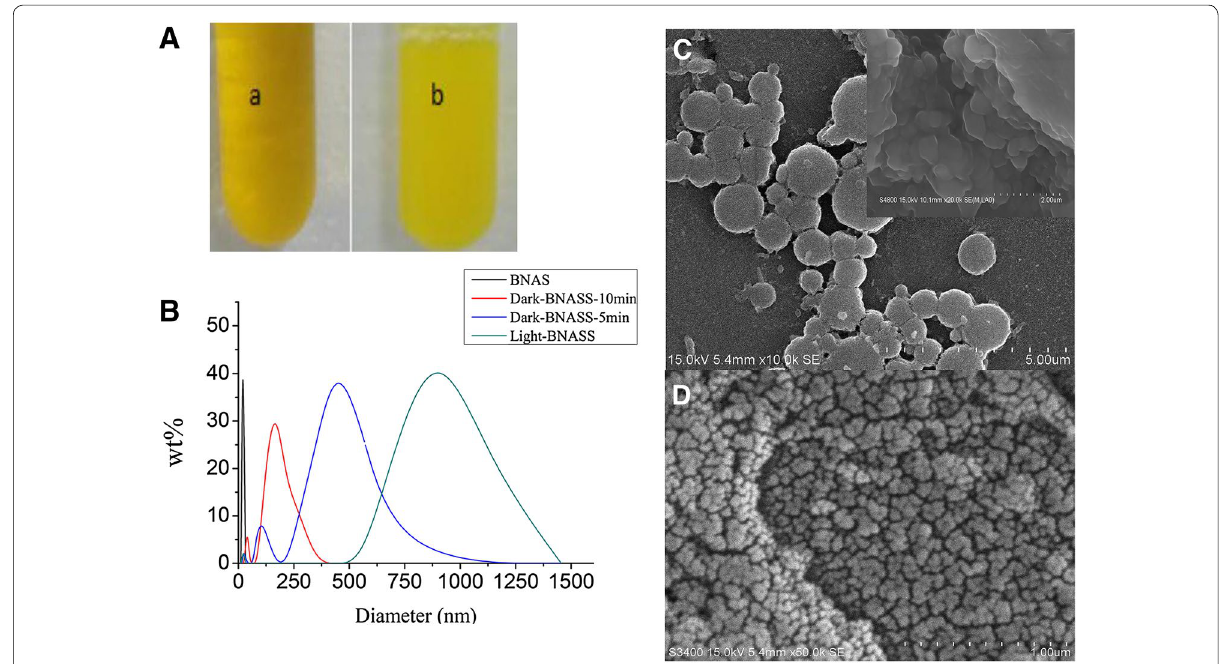
Fig. 3 The light-controlled assembly, disassembly, and morphology of the BCNIT-AsLOV2-SsrA-SspB (BNASS) complex in vitro. A The solution states of the mixture of BNAS, SspB, and FMN either ( a ) kept in the dark or ( b ) exposed to light. B Dynamic light scattering analysis of the hydrodynamic diameter of pure BCNIT-AsLOV2-SsrA (BNAS) and the mixture of SspB and BNAS. C Structure of the BNASS complex in vitro visualized by FESEM and SEM after illumination with blue light. D Structure of the BNASS complex in vitro visualized by SEM when the light is removed for 10 min. The reac- tions were carried out in an ice